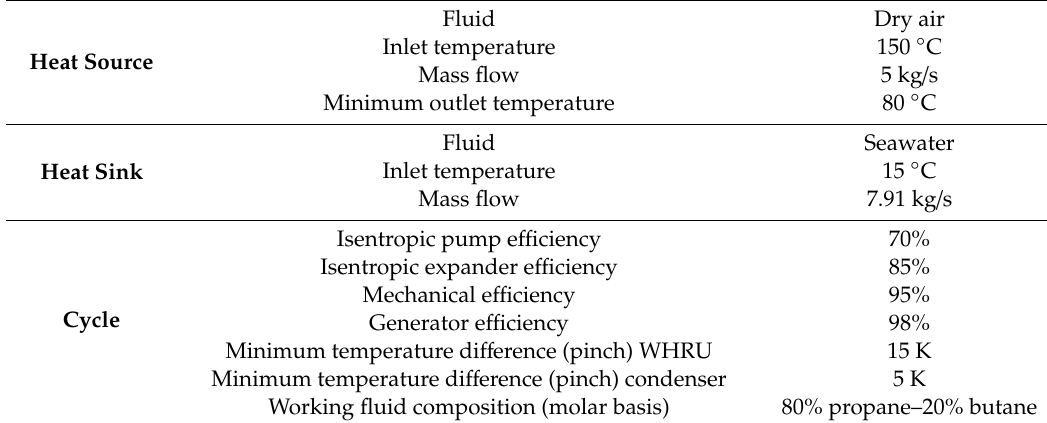
Table 1. ORC process details.